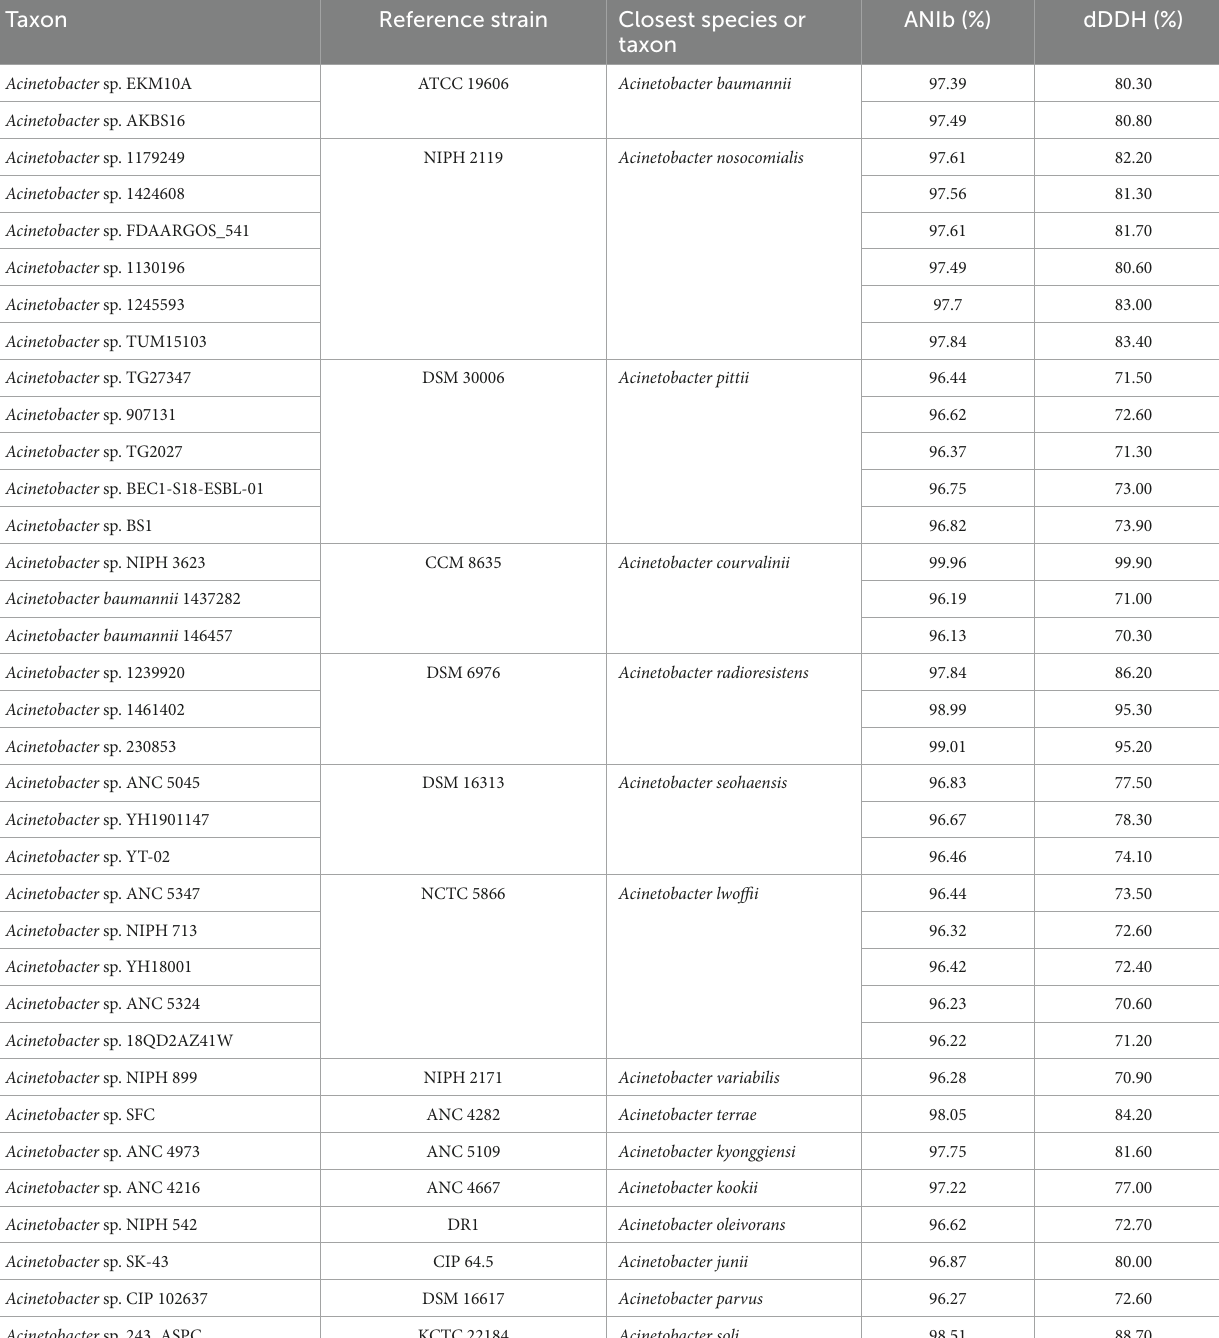
TABLE 1 Tentative taxonomic assignment of the unnamed Acinetobacter genus identified in this